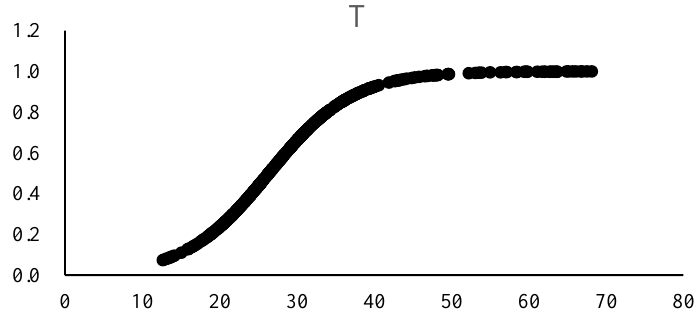
Figure 3. the transfer function image of industrial structure. Figure 3. The transfer function image of industrial